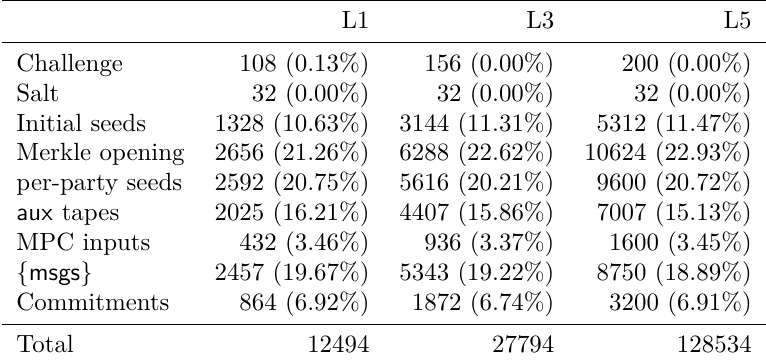
Table 11: Size breakdown of Picnic2 signatures, in bytes.